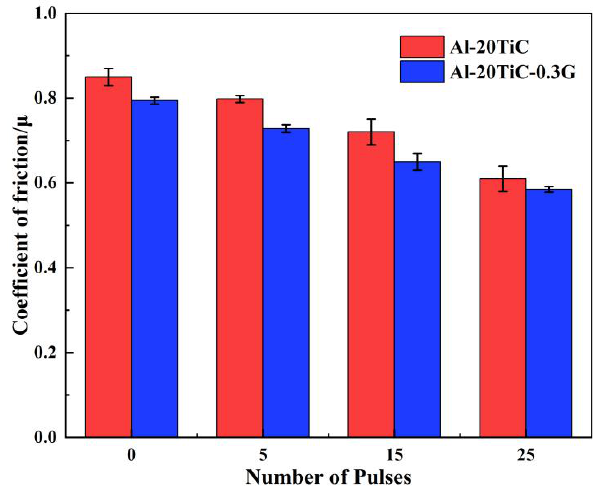
Figure 10. Variation of friction coefficient of Al-20TiC and Al-20TiC-0.3G composites with different number of pulses.